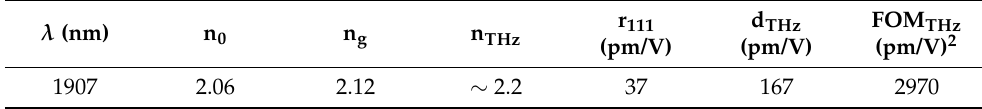
Figure 12. Optimum crystal length l opt ( ν , λ ) for the generation of THz waves as a function of the pump optical wavelength and the frequency of the generated THz wave for DSTMS, for both pump and THz waves polarized along the polar axis. Used with permission form the Royal Society of Chemistry, from [195]; permission conveyed through Copyright Clearance Center, Inc. Table 14. Main optical-THz characteristics of DSTMS.